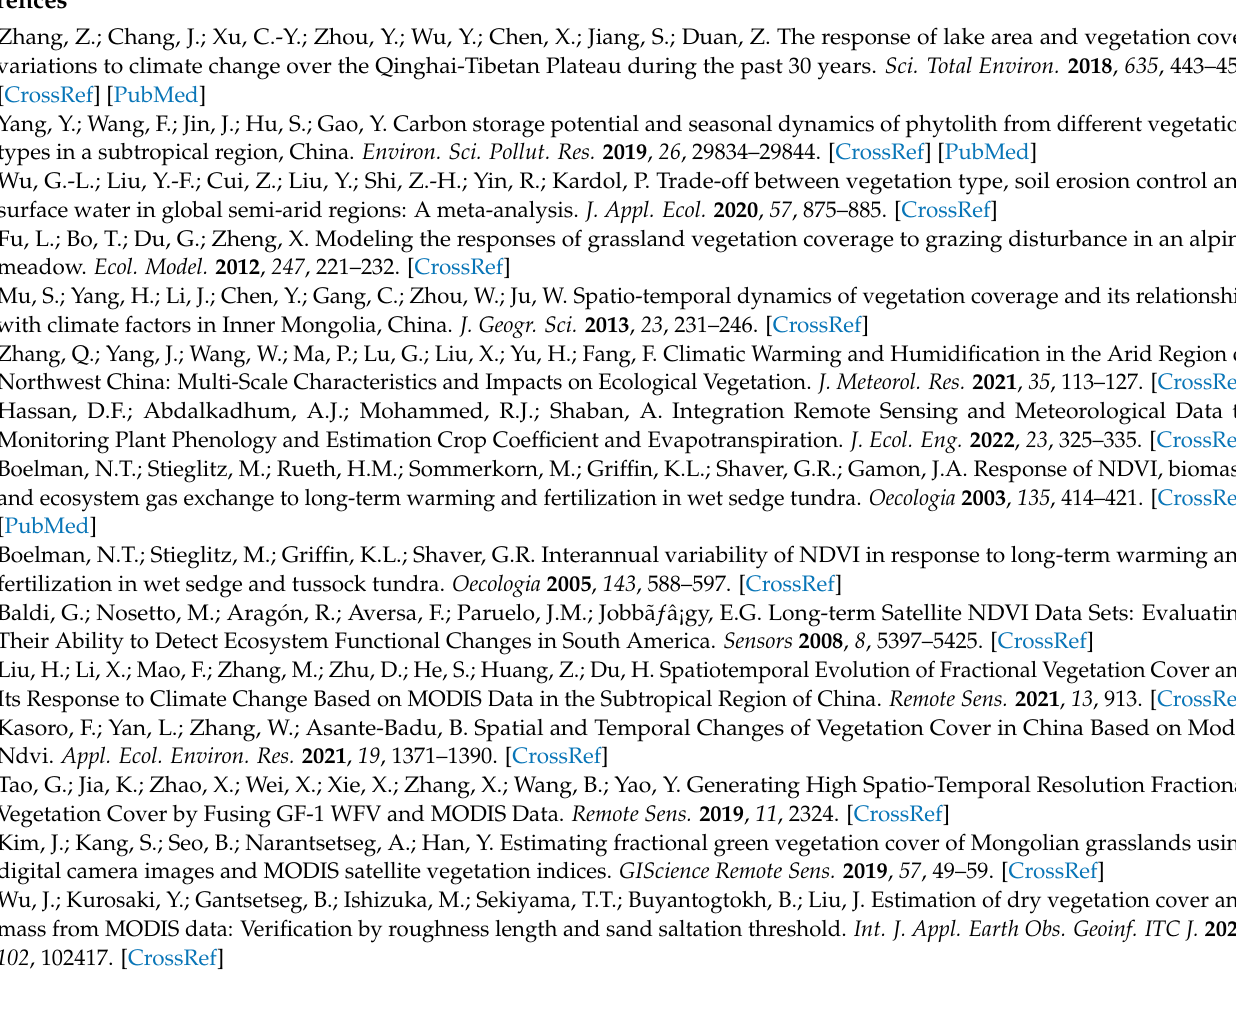
the Urumqi River basin; Table S1: Vegetation attribute table; Table S2: Landsat images information; Table S3: Values of NDVI veg and NDVI soil